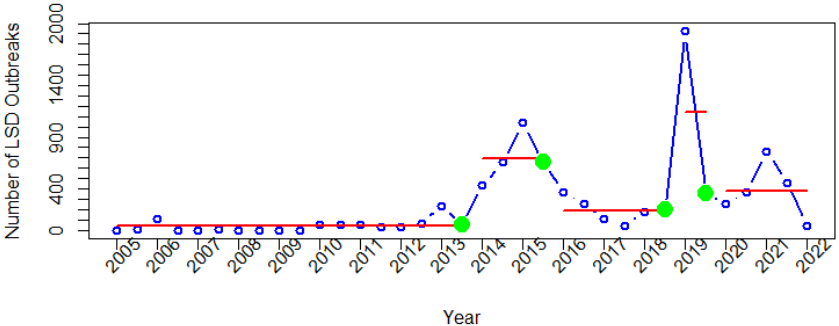
Figure 7. Change points in time series of LSD outbreak reports in Asia. Green dots are change points, and red lines are corresponding segments.